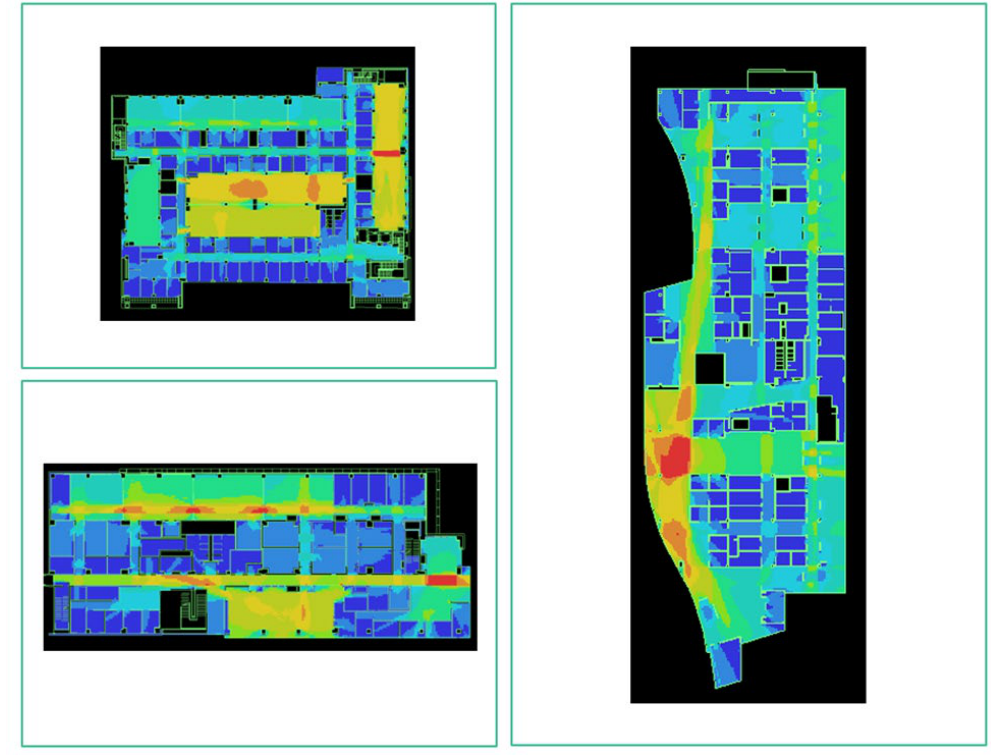
Figure 15 Visibility analysis of typical floor plans (Top left: Walther Hall, Bottom left: Neuroscience, and Right: CMRI). The layout of the Neuro building differs from the CMRI building in terms of lab space